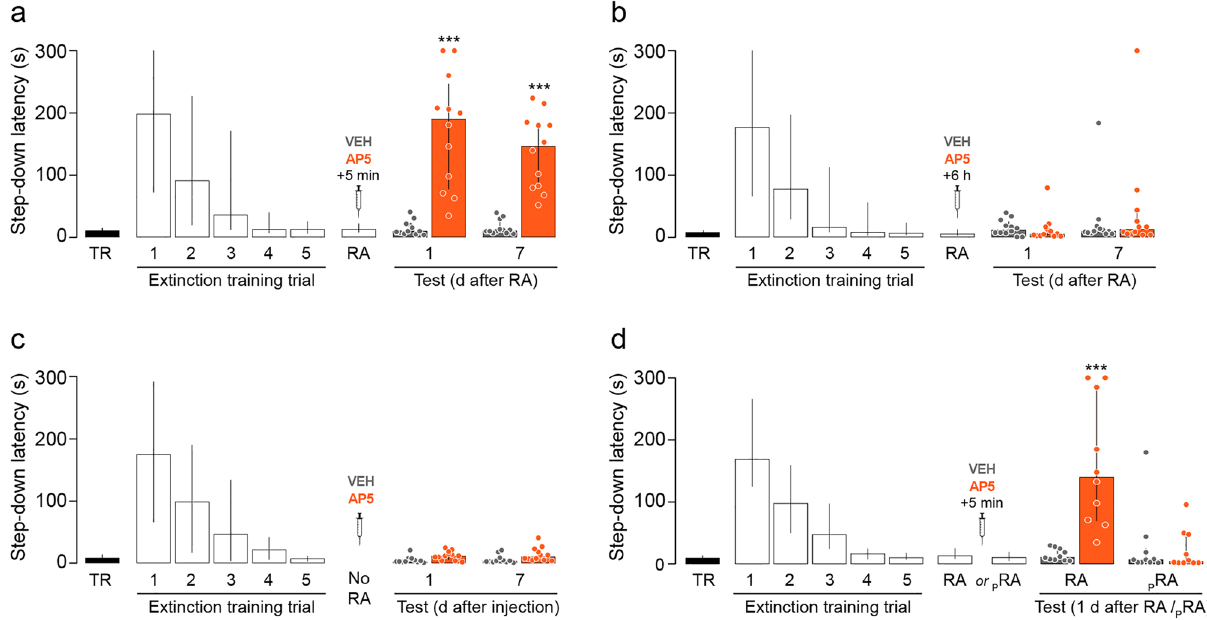
Figure 1. Post-recall NMDAR blockade hinders SDIA extinction memory and induces SDIA memory recovery. ( a ) Animals were trained in SDIA (TR; 0.4 mA/2 s) and beginning 24 h later they were submitted to one daily extinction training trial for 5 consecutive days. Twenty-four hours after the last extinction training trial, SDIA extinction memory was reactivated (RA) and, 5 min thereafter, the animals received bilateral intra-dorsal CA1 infusions of vehicle (VEH; 1% DMSO in saline) or the NMDAR antagonist AP5 (5 µg/side). Retention was assessed 1 day and 7 days later (Test). ( b ) Animals were treated as in A except that they received intra-CA1 infusions of VEH or AP5 6 h after RA. ( c ) Animals were treated as in A, except that RA was omitted (No RA). ( d ) Animals were treated as in A, but a group of them received VEH or AP5 5 min after a pseudo-reactivation extinction session (pRA) carried out in an SDIA training box modified to be non-aversive (NA) for SDIA- trained animals (test latency in SDIA: Median = 162 s; IQR = 74–244.5 s; test latency in NA: Median: 10 s; IQR = 7.5–17.5 s; U = 3.00, p = 0.0003, SDIA vs NA in Mann–Whitney test). The non-aversive box was similar in dimensions to the SDIA-training apparatus but was painted gray and the elevated platform was made